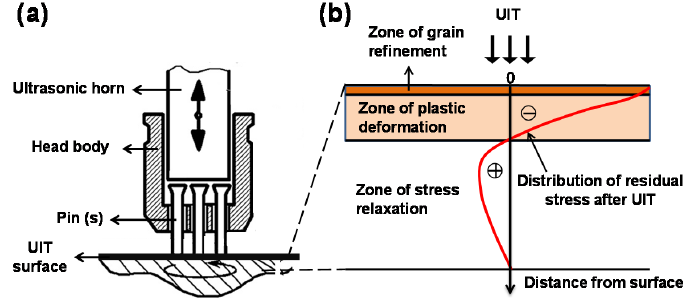
Figure 1. ( a ) Schematic view of the impact head of ultrasonic impact treatment (UIT); ( b ) Sectional view of the surface region for the sample treated by UIT.